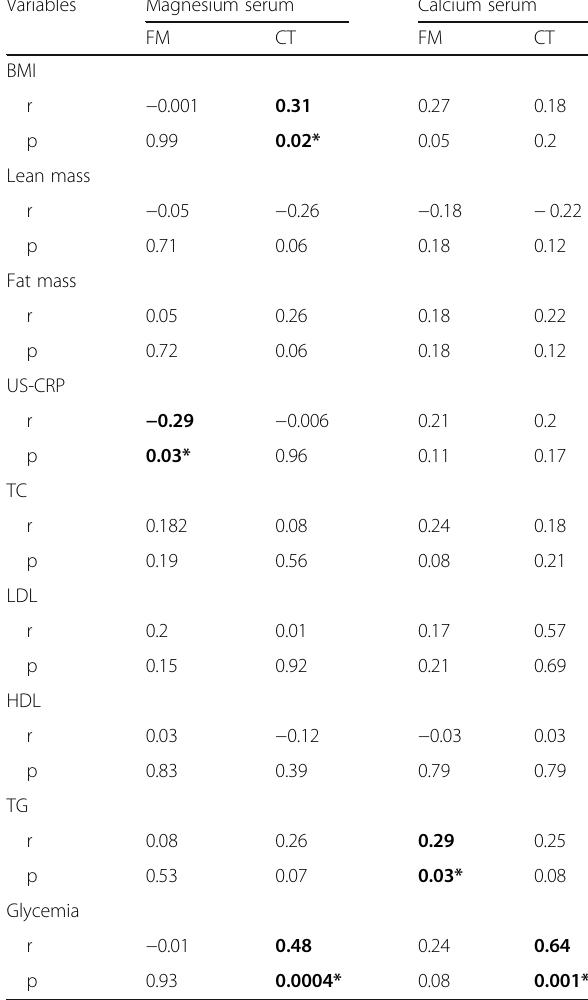
Table 2 Relationship between serum magnesium and calcium levels with the variables: body composition and metabolic parameters Variables